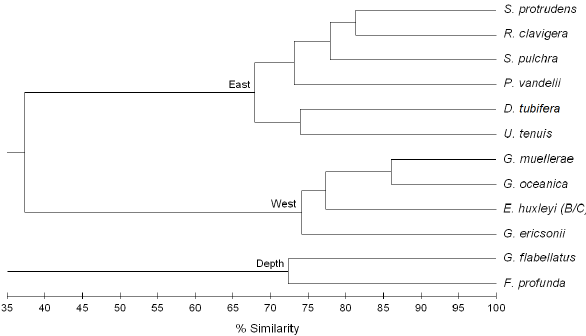
Figure 5. Hierarchical cluster for the heterococcolithophores species that shared more than 65% similarity in their abundance and distribution patterns.